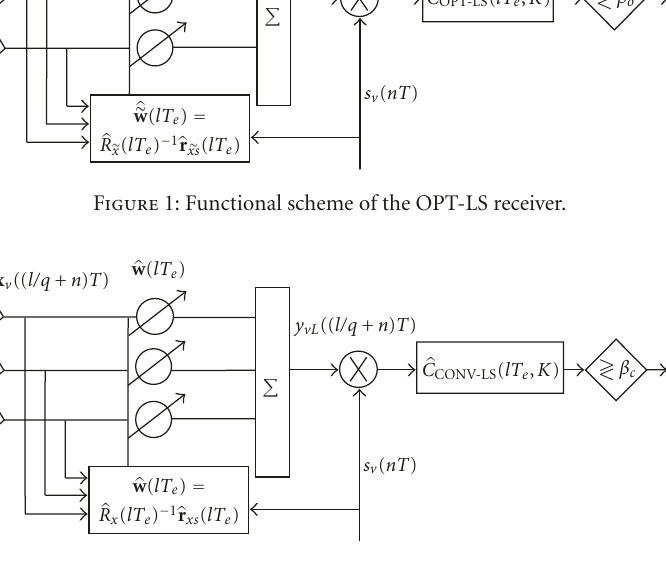
Figure 2: Functional scheme of the CONV-LS